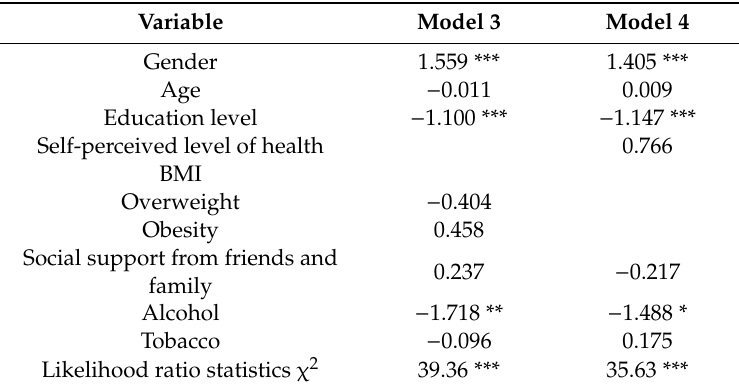
Table 3. Results of logit regression of level of PA at